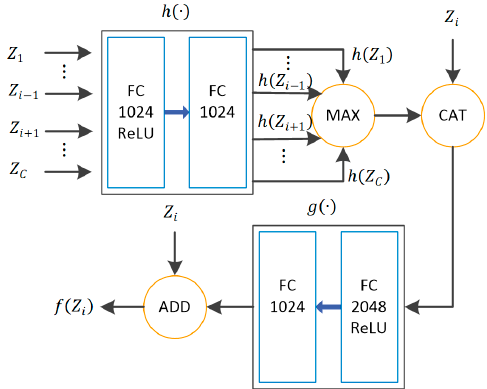
Figure 4. Illustration of set-to-set transformation. MAX denotes the max-pooling operation, CAT denotes vector concatenation, and ADD denotes vector addition.